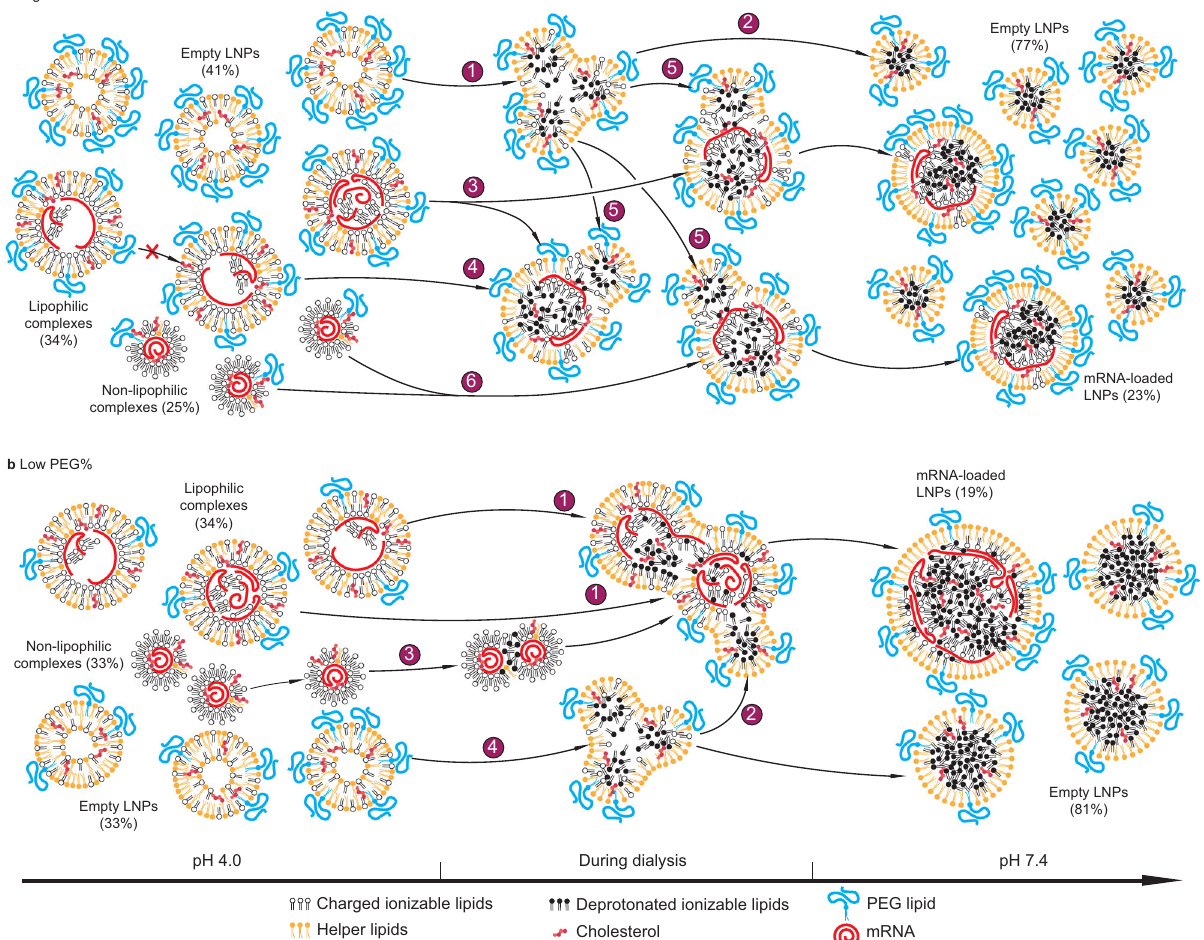
Fig. 4 | Mechanisms of determination of payload capacity and distribution of mRNA LNPs by the PEG content. a , b The hypothesized assembly processes and characteristics of LNP formulation with a high concentration of PEG mol% ( a ); or a low concentration of PEG mol% ( b ) and composition drift during dialysis from pH 4.0(left)topH7.4(right).Thepopulationalfractionslabeledarerealdatafromthe formulation with PEG mol%=1.5% ( a )or0.5%( b ). a Each number labelrepresents a populational behavior during dialysis: 1, splitting of empty LNPs; 2, stabilization of empty LNPs; 3, splitting of lipophilic complexes with an initially high mRNA